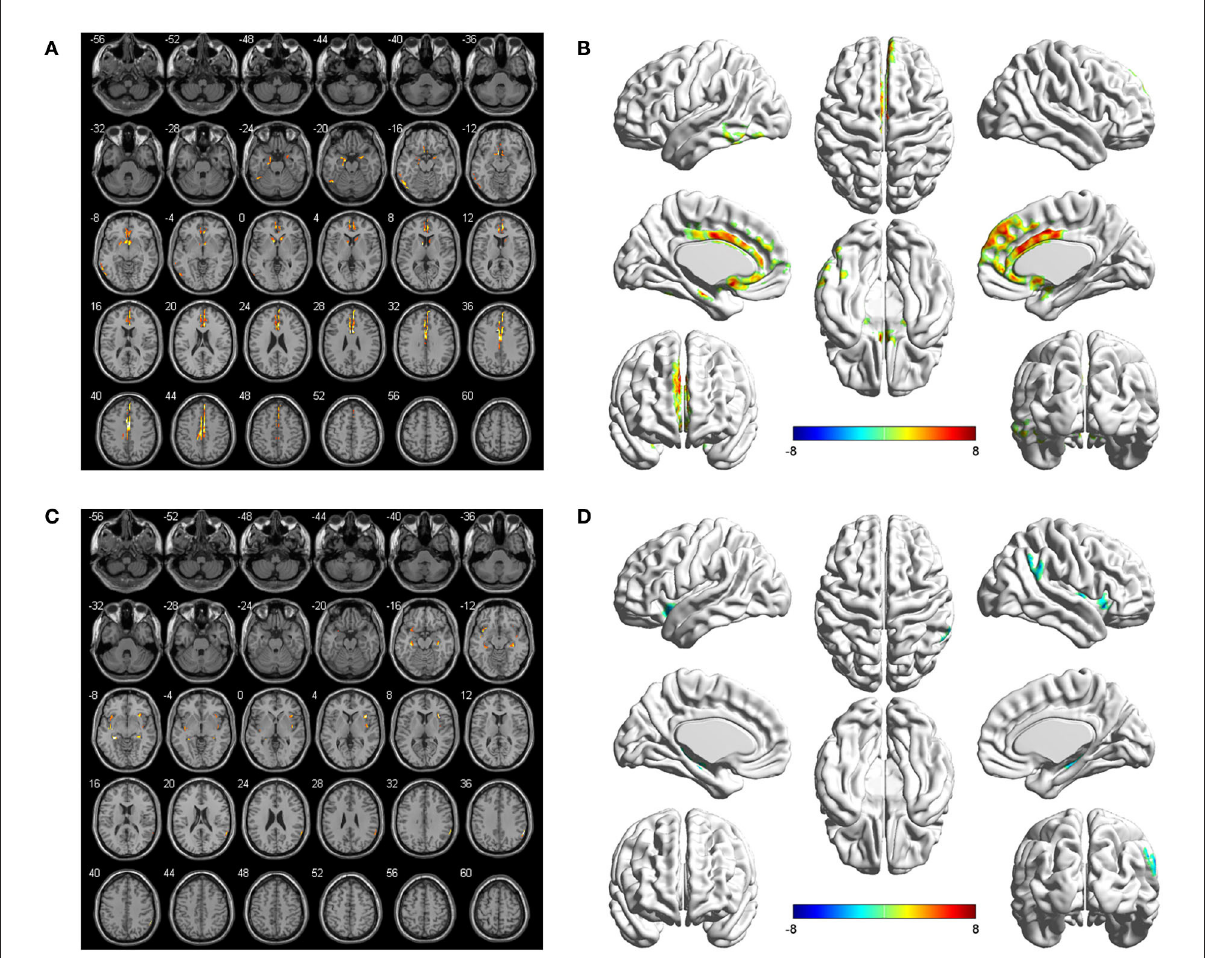
FIGURE2 Differences in the left hippocampal connectivity between patients with ruptured ACoA aneurysm and healthy controls. Compared with the control group, brain regions labeling with color indicate decreased (upper panel) or increased functional connectivity (lower panel) in patients with ruptured ACoA aneurysm. Results were displayed in 2D (A,C) and 3D (B,D) , respectively. The displaying threshold was set to p < 0.05, false discovery rate corrected, and cluster size > 50. Details of abnormal connectivity regions are shown in Table 2. ACoA, anterior communicating